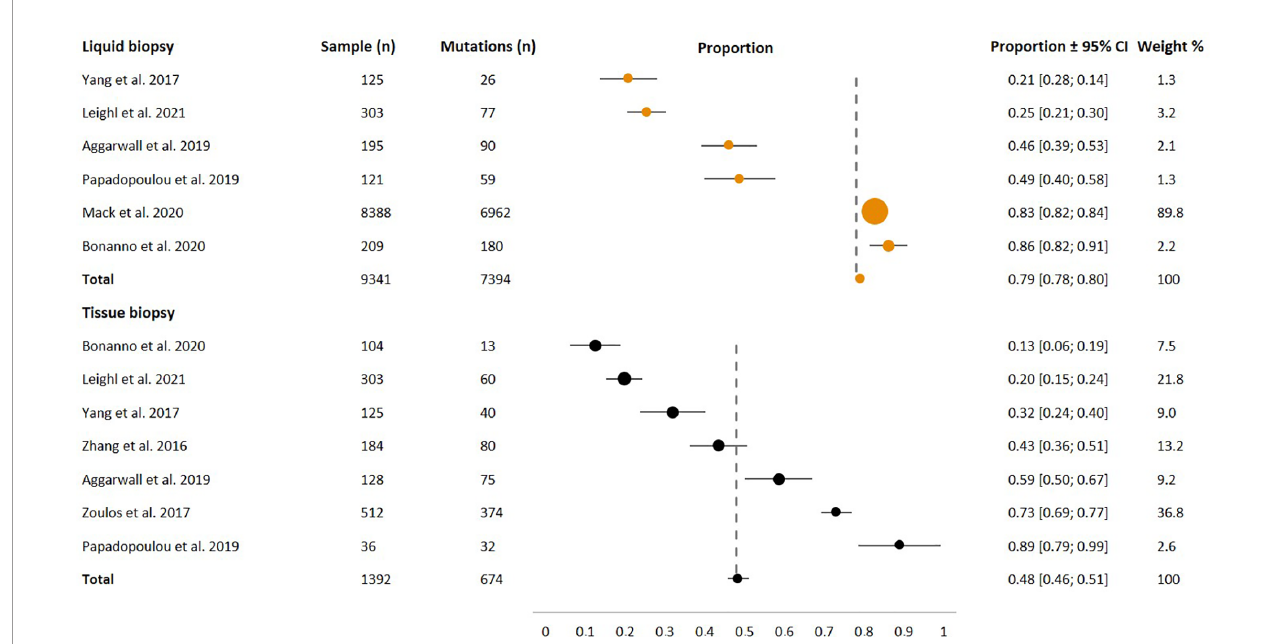
FIGURE 2 | Forest plot of the extracted data from 8 studies: 6 studies utilizing liquid biopsy samples (n = 9341), and 7 studies utilizing tissue biopsy samples (n = 1392). Dashed line shows the weighted mean proportion of somatic mutations (0.79 for liquid biopsy and 0.48 for tissue